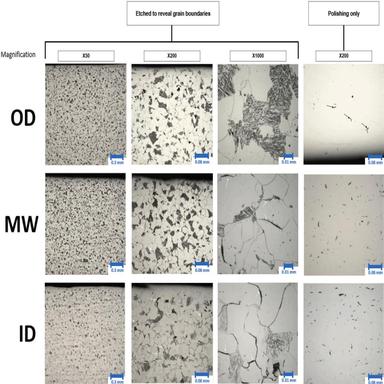
Metallographic study of OD, MW, and ID HTHA samples.